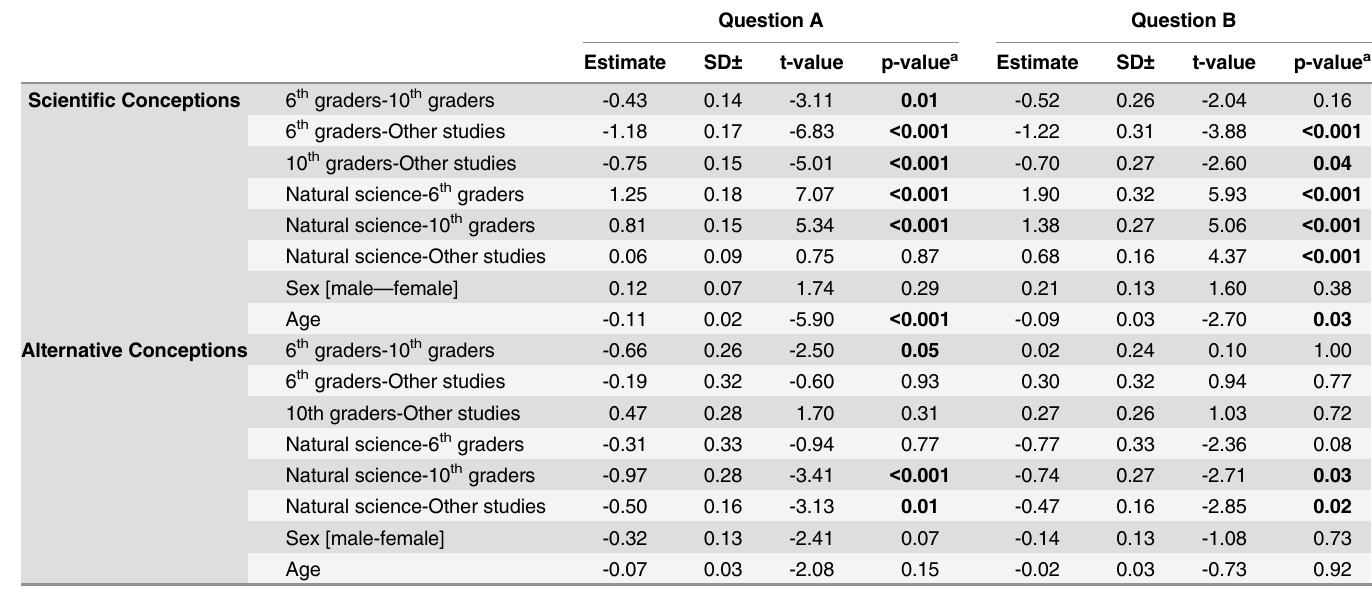
Table 1. Effect of educational background on expression of scientific and alternative conceptions tested with ordered logistic regressions and pre-defined model contrast for multiple comparisons among educational backgrounds (n =